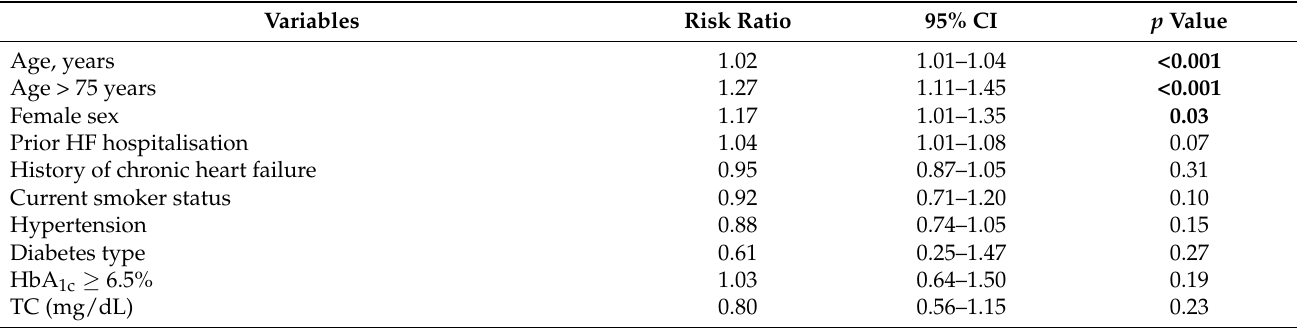
Table 3. Univariate Cox proportional-hazards regression analysis for